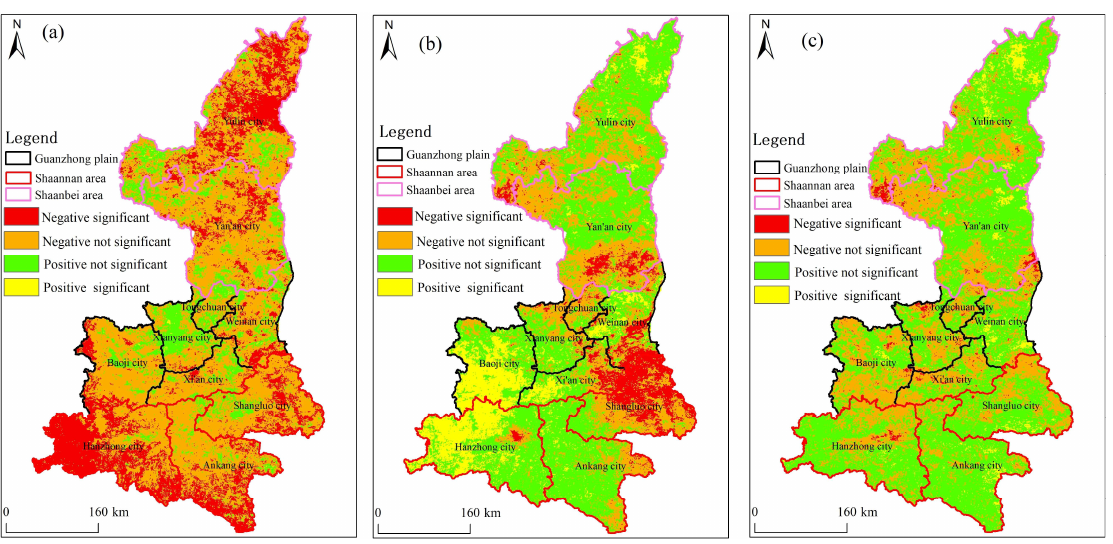
Figure 13. The correlation coefficient classification map between TVDI and meteorological factors. ( a ) Precipitation. ( b ) Annual average temperature. ( c ) Temperature anomaly.